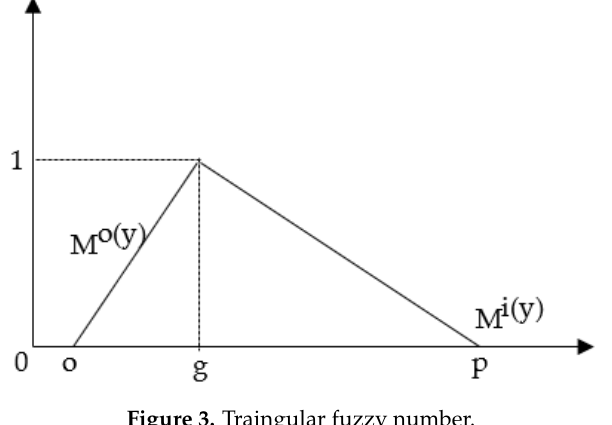
Figure 3. Traingular fuzzy number.